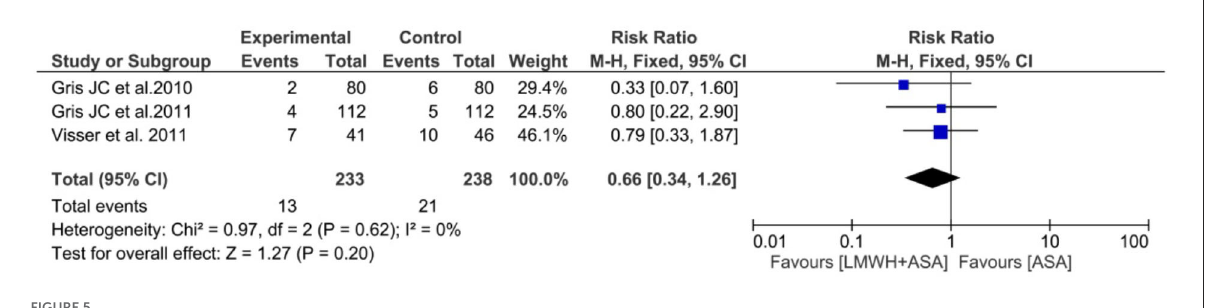
FIGURE5 Meta-analysis of intrapartum or postpartum hemorrhage.